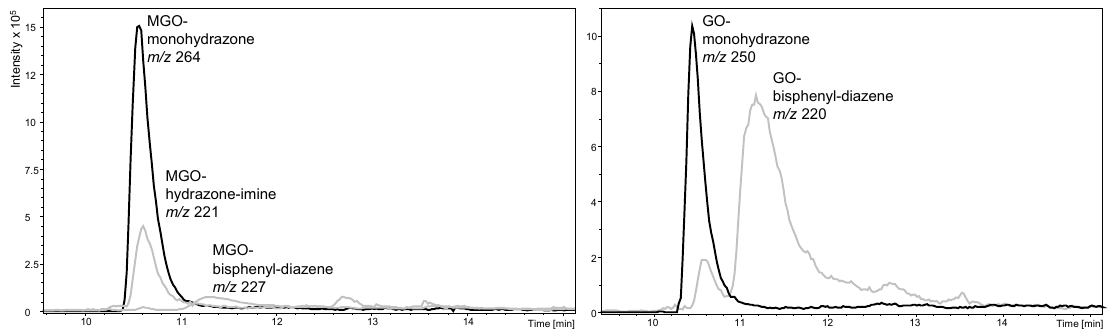
Figure 5. LC-ESI-MS analysis of the reaction mixtures from the derivatization of MGO ( left ) and GO ( right ) with 3-AEH after 1 h incubation time in aqueous ACN. Black: ion current of selective mass traces (extracted ion chromatogram) for the monohydrazone derivatives of MGO, m/z 264, and GO, m/z 250. Grey: ion current of selective mass traces of the MGO hydrazone-imine and bisphenyldiazene ( m/z 221 and 227) and GO bisphenyldiazene ( m/z 220) derivatives.